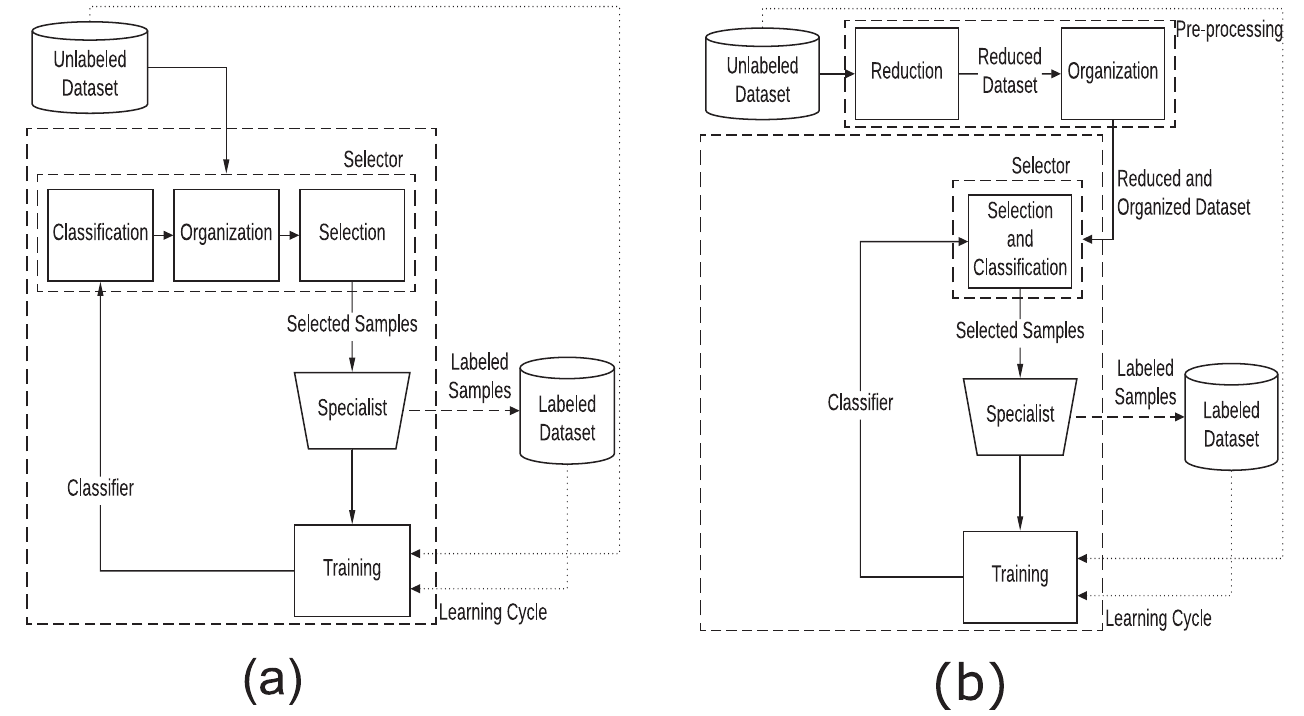
Fig 1. Workflow of the active semi-supervised learning. (a) traditional paradigm. (b) adopted paradigm.